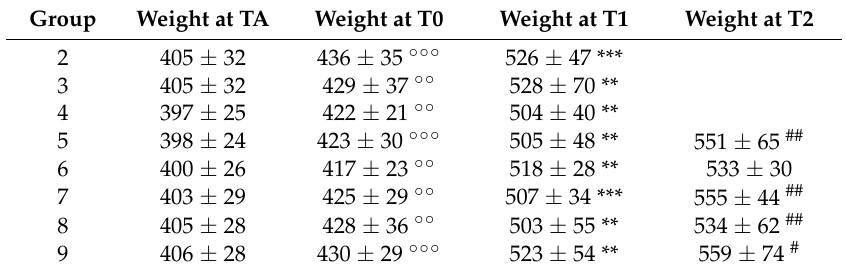
Figure 1. Schematic drawing showing the rats randomized in groups for the different experimental conditions. Group 2: control, normal diet for 4 weeks. Group 3: calcium-deprived diet for 4 weeks. Group 4: calcium-deprived diet with concomitant administration of PTH (1-34) 40 µ g/kg/day for 4 weeks. Group 5: calcium-deprived diet for 4 weeks and successive normal diet restoration for 4 weeks. Group 6: calcium-deprived diet for 4 weeks and successive normal diet restoration with concomitant administration of PTH (1-34) 40 µ g/kg/day for 4 weeks. Group 7: calcium-deprived diet with concomitant administration of PTH (1-34) 40 μ g/kg/day for 4 weeks and successive normal diet restoration for 4 weeks. Group 8: calcium-deprived diet with concomitant administration of PTH (1- 34) 40 μ g/kg/day for four weeks and successive normal diet restoration with concomitant administration of PTH (1-34) 40 μ g/kg/day for 4 weeks. Group 9: control, normal diet for eight weeks. Table 1. Body weights of rats at the time of arrival (TA), at the beginning (T0), after four weeks (T1), and after eight weeks (T2) of experimentation.